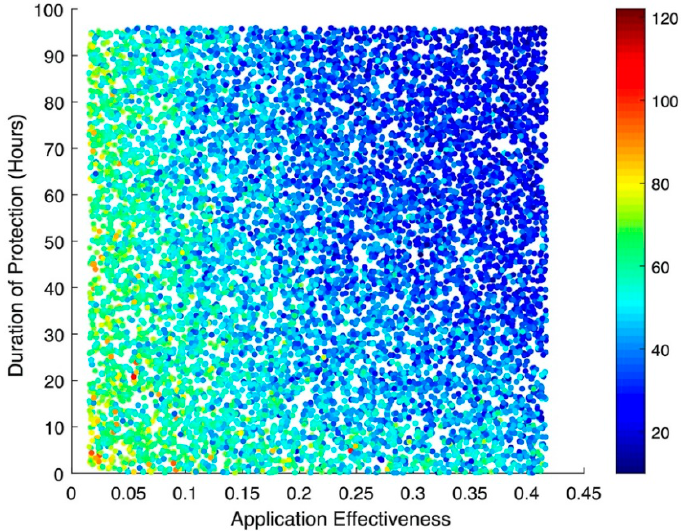
Figure 3. Scatterplot of incident MRSA acquisitions in an 18-bed ICU over a simulated year. Each dot represents one of 10,000 iterations of a stochastic model, simulating a spread of possible levels of effectiveness and duration of protection for a hypothetical long-acting decolonization agent.